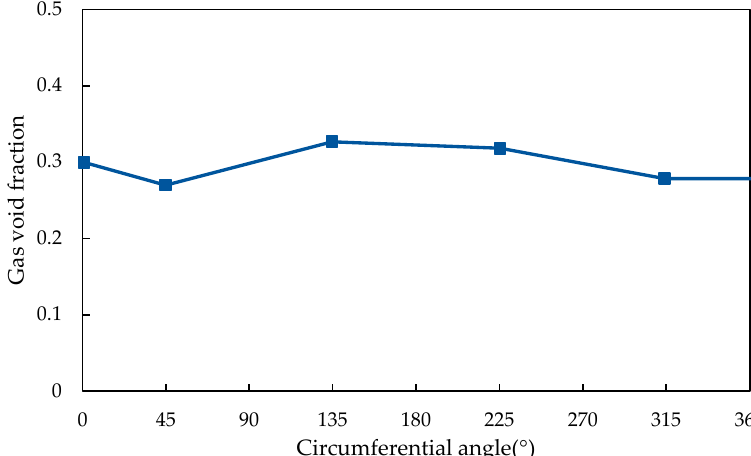
Figure 13. Gas void fraction with circumferential angle.